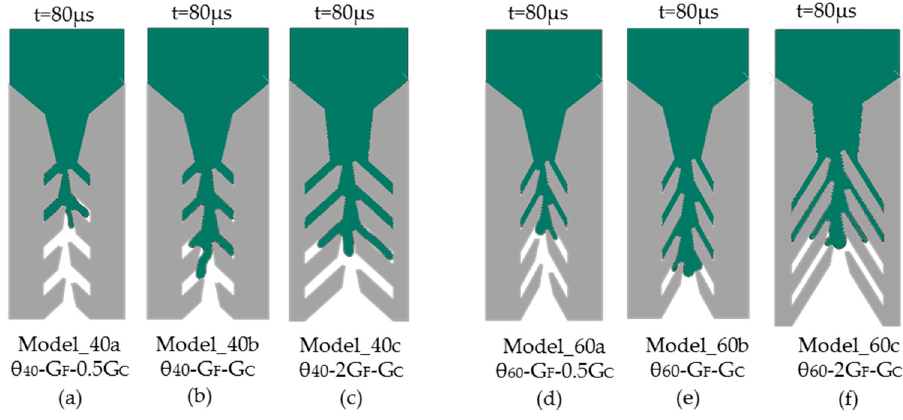
Figure 11. Infiltrated CMAS height at time of 80 µ s simulated for six top coat morphologies. Infiltration depths are shown for: ( a ) Model_40a; ( b ) model_40b; ( c ) model_40c; ( d ) model_60a; ( e ) model_60b; and ( f ) model_60c.